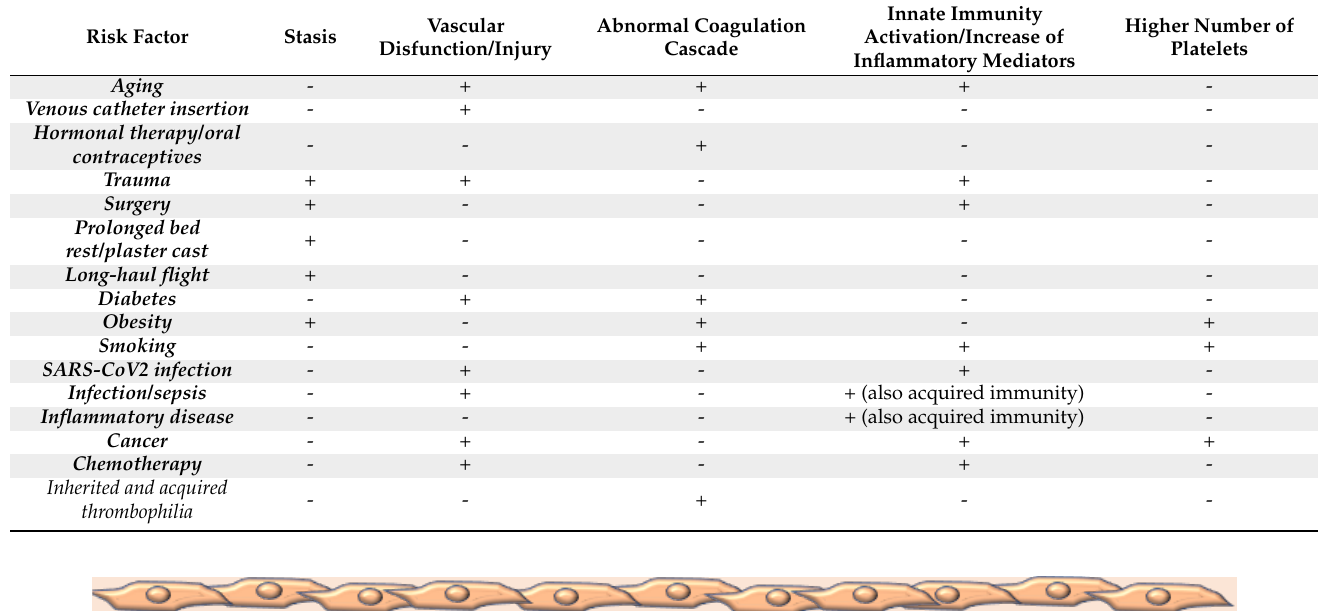
Table 3. Pathogenesis of risk factors for VTE.